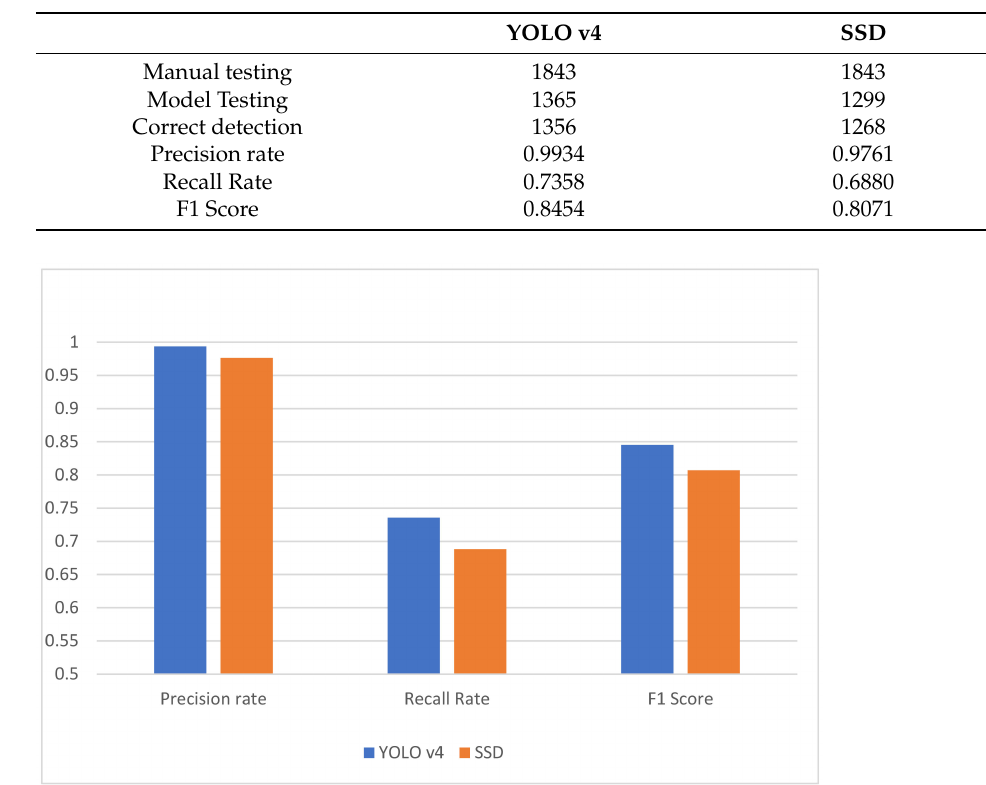
Table 5. Comparison table of target detection accuracy.